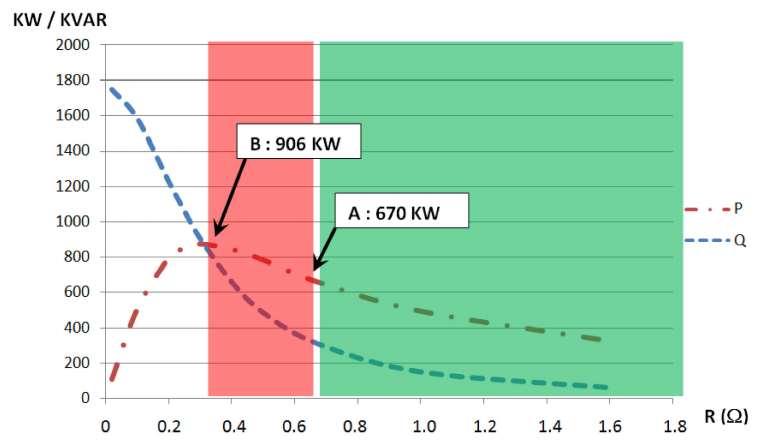
Figure 32. The load associated to the generator is a pure resistance. It evolves from 0 Ω to 1.6 Ω . In this Figure, the power is plotted as a function of the resistance. The reactive power is plotted with the same scheme, this reactive power is the reactive power delivered by the pure voltage source. It takes into account the internal reactance of the machine.